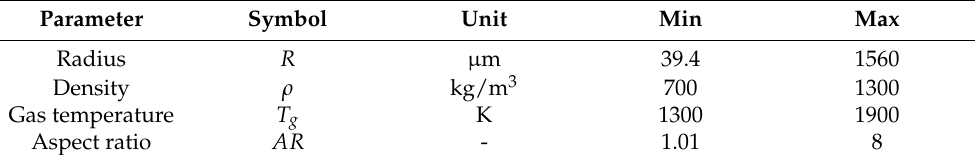
Table 2. Input parameter span.